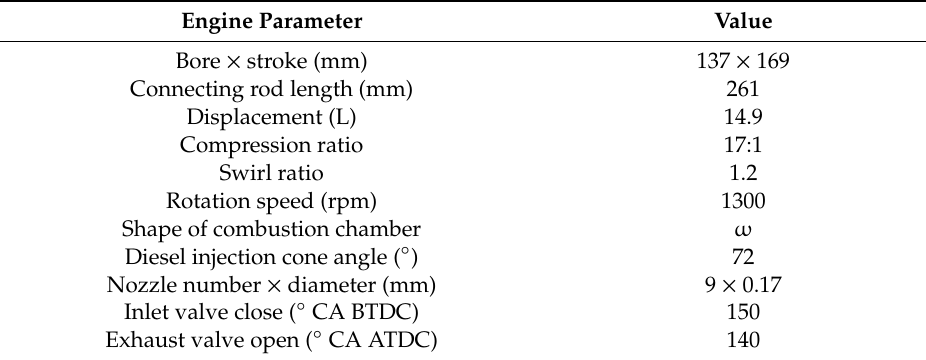
Table 1. Main technical parameters of the